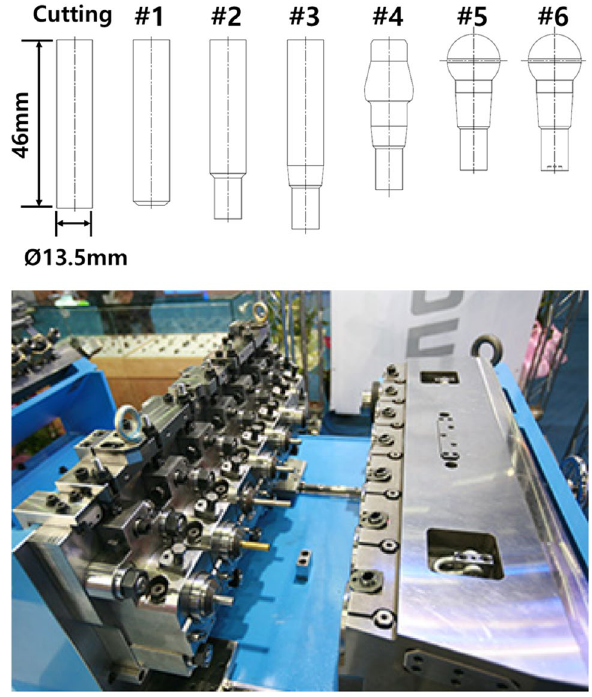
Figure 6. Multi-stage cold forging process design with forming apparatus.